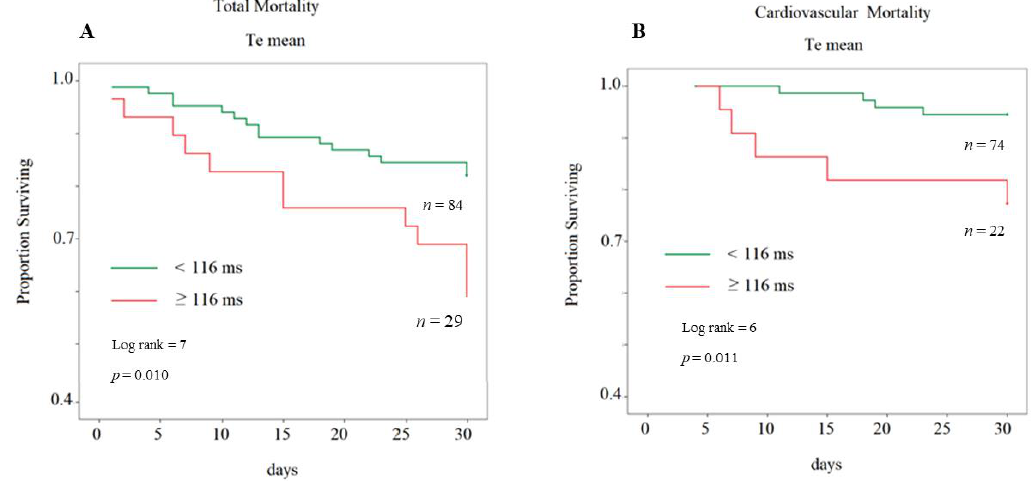
Figure 4. ( A ) Kaplan – Meier survival curve for total mortality by subdividing the study subjects with a cuto ff at the 75th percentile of mean Te. ( B ) Kaplan–Meier survival curve for cardiovascular mortality by subdividing the study subjects with a cutoff at the 75th percentile of mean Te.